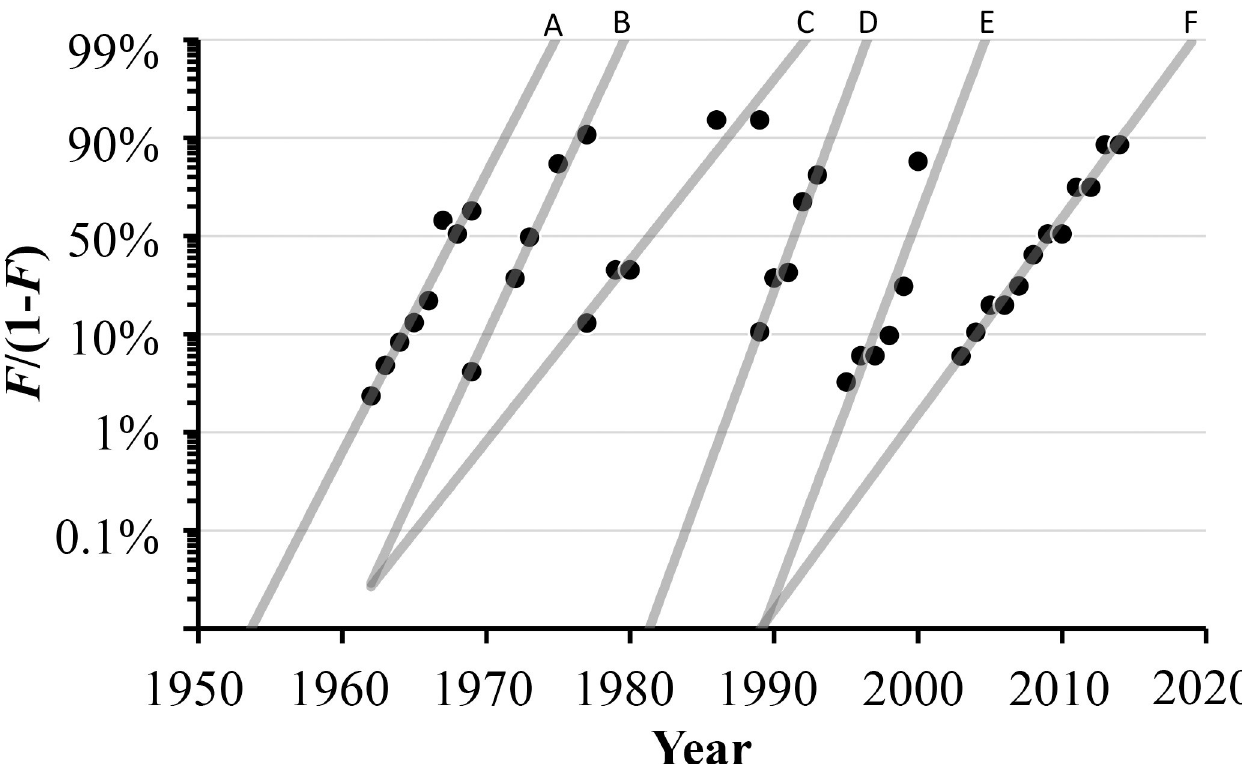
Fig 6. Decomposition and linearization of data into corresponding individual loglet trends highlighting distinct phases of transistor evolution. See Table 3 for fitted model parameter values.